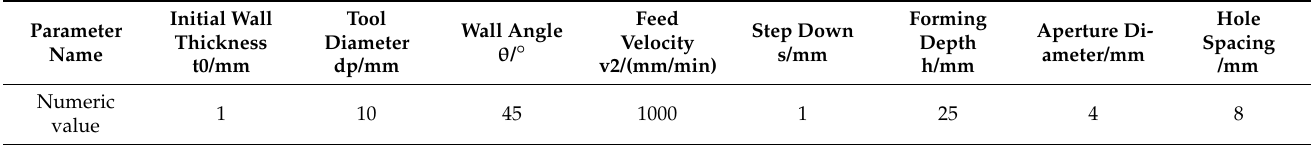
Table 2. Perforated titanium sheet incremental forming process